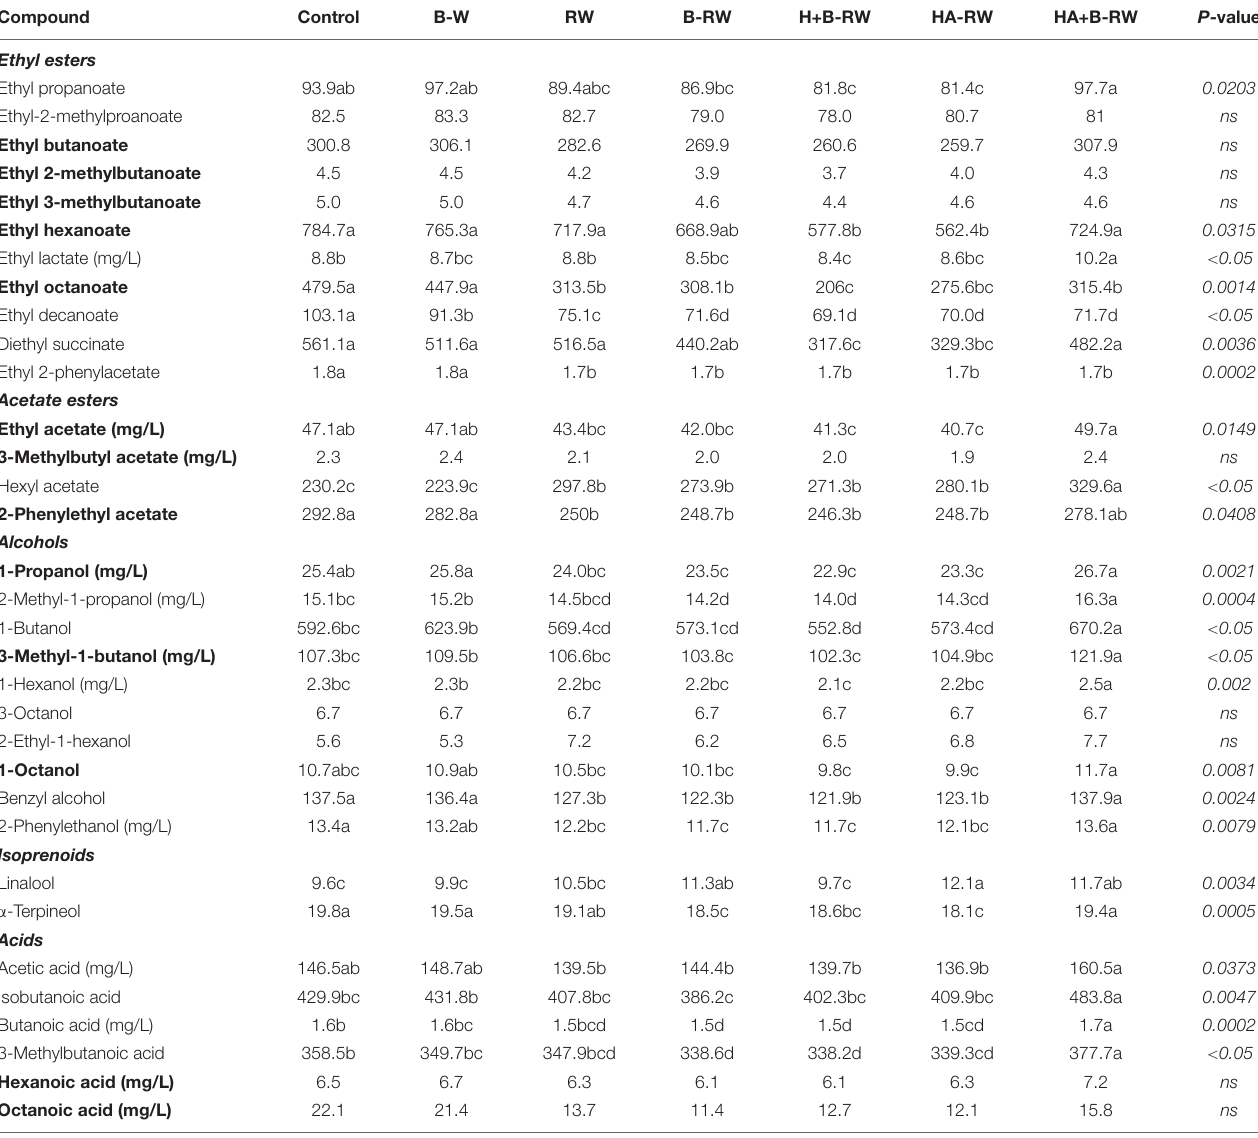
TABLE 2 | Concentrations of volatile compounds determined in untreated wine (Control), wine treated via bentonite fining (B-W) as a positive control, and recombined wines (RW) following ultrafiltration/heat/protease treatments; B denotes bentonite addition; H denotes heating (10 min at 62 ◦ C); A denotes Aspergillopepsin enzyme addition (DSM 0.05%